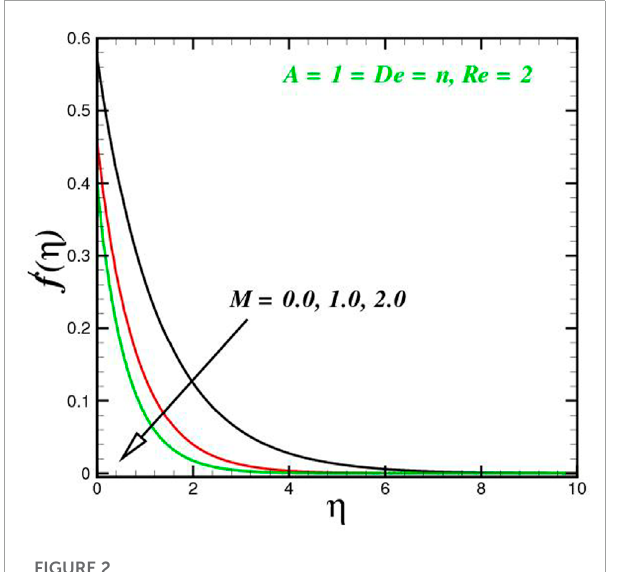
FIGURE 4 f ′( η ) , alteration via Re.